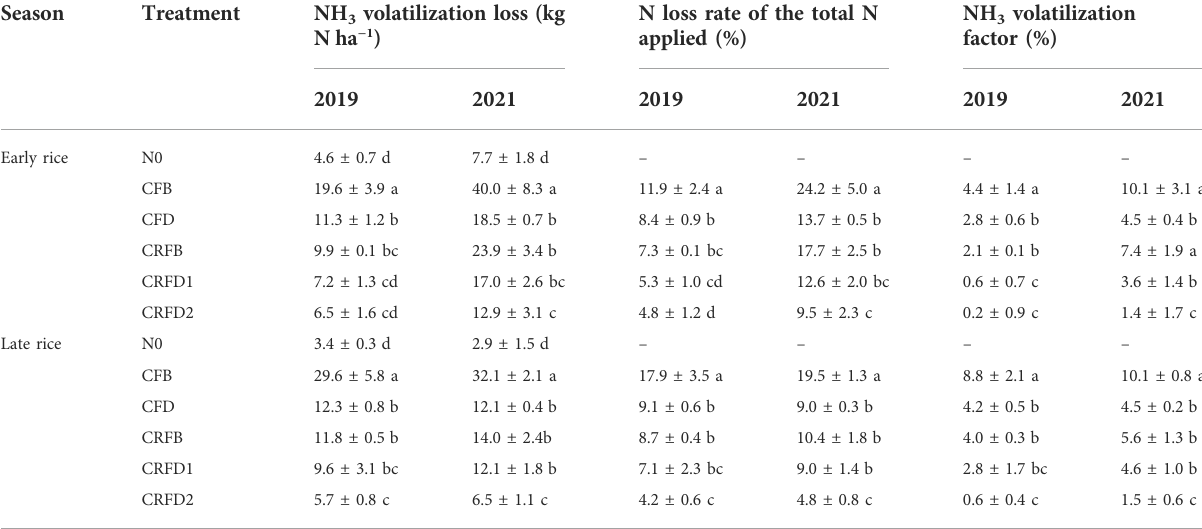
Values are presented as the mean ± standard deviation (n = 3). Different lowercase letters within the same column indicate signi fi cant difference at p < 0.05. N0: no N fertilizer; CFB: compound fertilizer broadcasting; CFD: compound fertilizer side-deep placement; CRFB: controlled-release N fertilizer broadcasting; CRFD1: controlled-release N fertilizer side-deep placement; CRFD2: controlled-release N fertilizer side-deep placement, one-time